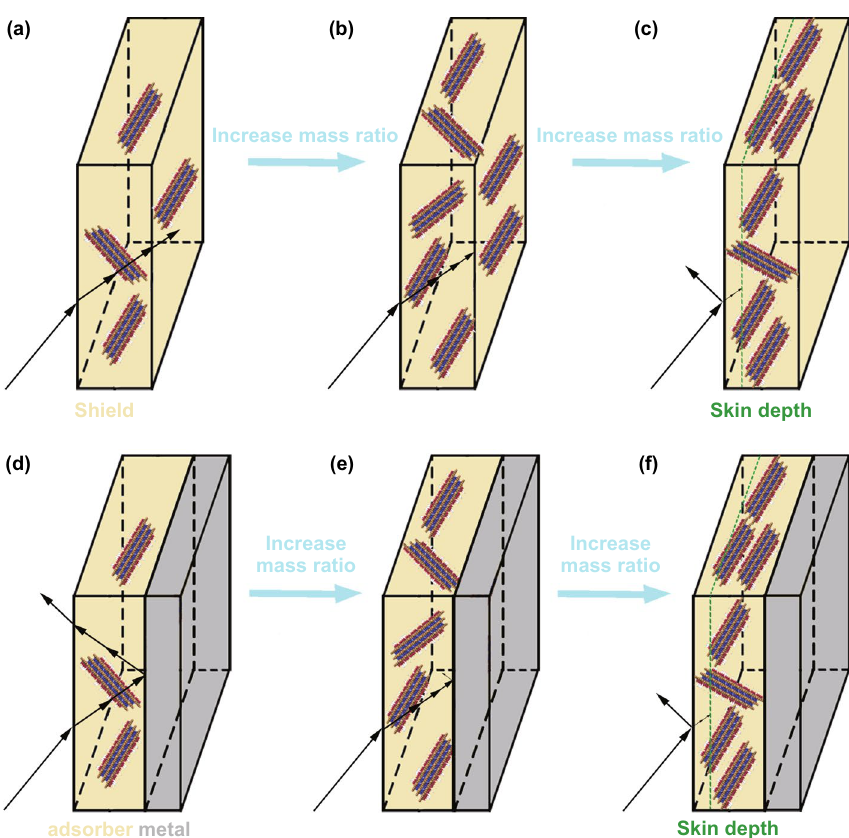
Fig. 2 Situations in which the EMI shield responds to the EM wave: a allowing all waves to enter with large transmission, b allowing all waves to enter with no transmission, and c strong secondary reflection. The situations in which the absorber responds to the EM wave: d good imped‑ ance matching with weak attenuation, e an ideal absorber with good impedance matching and strong attenuation, and f poor impedance matching with strong